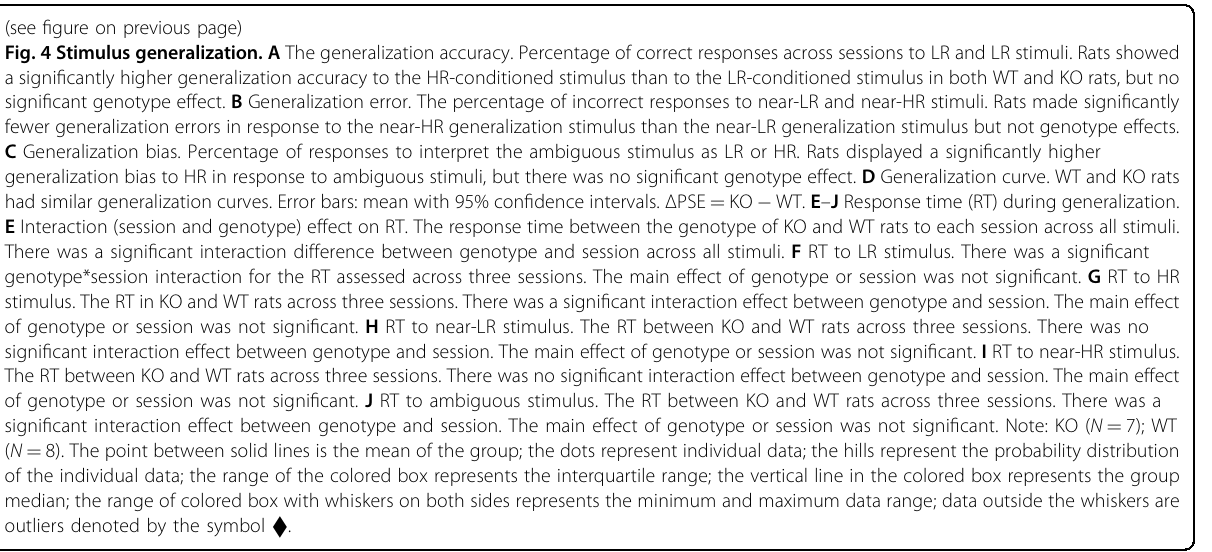
(Fig. 4I), there were no signi fi cant effects (genotype: E = [ − 0.30, 0.36]; genotype*session: E = 0.47, CrI = [ − 0.14, 1.09]). For the ambiguous stimulus (Fig. 4J), there was a signi fi cant interaction effect between genotype and ses- sion ( E = 0.74, CrI = [0.09, 1.49]). No other signi fi cant effects were found (genotype: E = − 0.47, CrI = [ − 1.15, 0.29]; session: E = 0.00, CrI = [ − 0.33, 0.36]). We con-